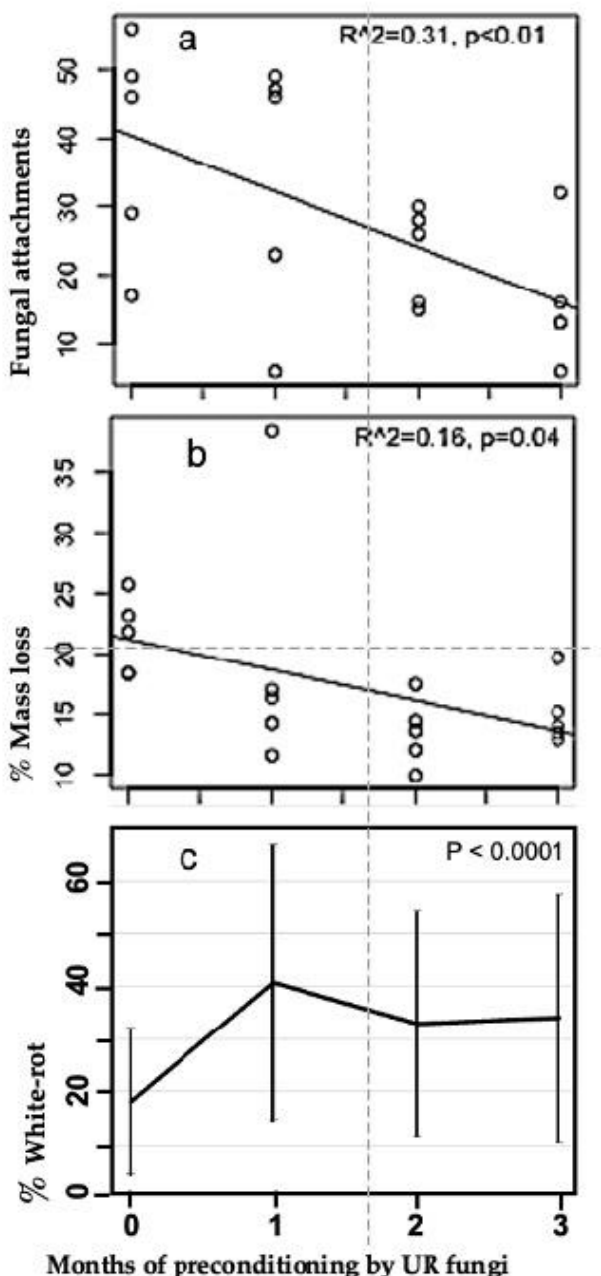
Figure 2. Basidiomycete fungal attachments, mass loss and % white-rot in Manilkara bidentata leaves exposed to 0, 1, 2 and 3 months of pre-conditioning by unit restricted (UR) microfungi and measured 6 weeks after placement on white-rot fungal litter mats in wet tropical forest at El Verde, Puerto Rico. ( a ) Number of basidiomycete fungal attachments (hyphal strands, cords and rhizomorphs) connecting leaves in litterbags to the white-rot litter mat below. ( b ) % mass loss. ( c ) % white-rot (means +/ − SD).